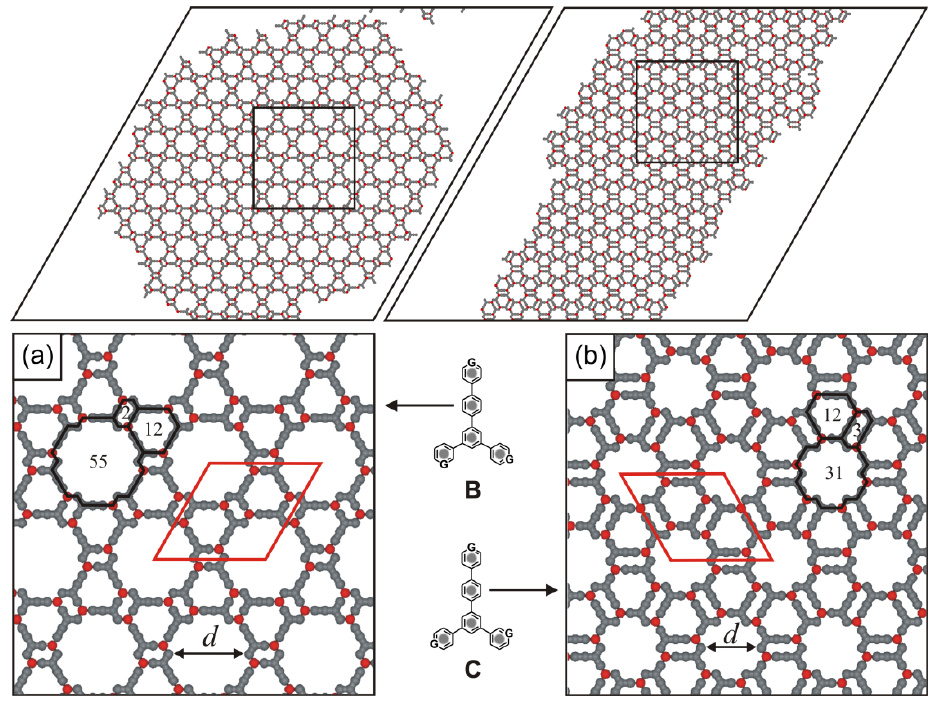
Figure 3. ( a ) Multiporous metal–organic network composed of 600 metal atoms and 600 ligands B in a 1:1 stoichiometric ratio; ( b ) openwork phase comprising 600 metal atoms and 600 ligands C . In the magnified fragments of the metal–organic patterns, rhombic unit cells are marked (solid red lines). The solid black lines mark the edges of nanopores differing in size and shape. Inside the highlighted nanopores, the numbers of empty adsorption sites are given. For the largest gear-like shaped nanopores, their diameters d (corner-to-corner) are marked.